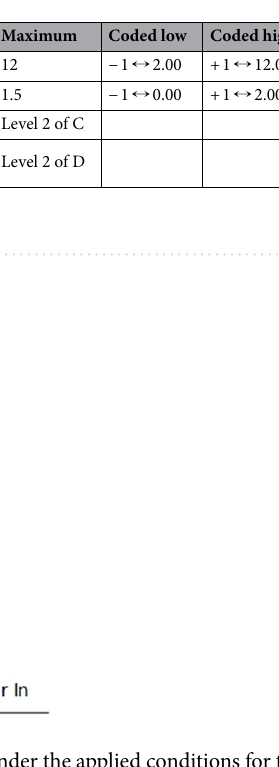
Figure 5. Schematic representation of T. versutus culture under the applied conditions for the abiotic